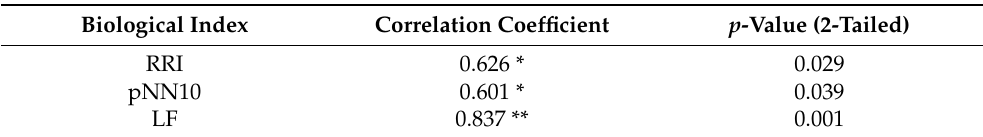
Table 11. Correlation coefficients between the number of errors in Task1 and the mean values of biological indexes during the latter half of Task1 (* correlation is significant at the 0.05 level; ** correlation is significant at the 0.01 level).